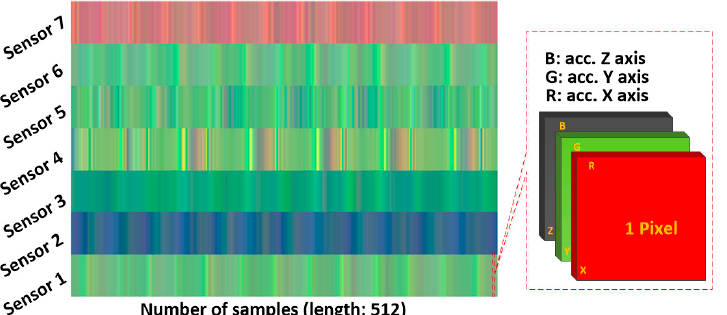
Figure 3. Multichannel RGB color plot on time domain. The segment length is 512 and the sampling rate is 50 Hz (image resolution 512 × 7 pixels).